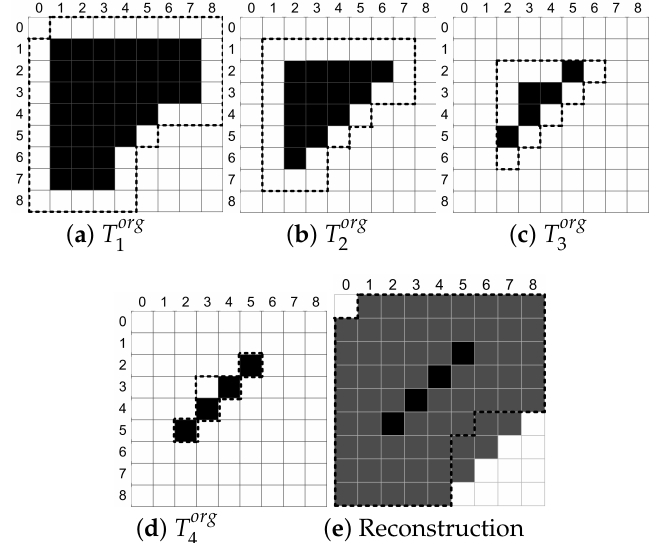
Figure 10. ( a – d ) The original thinning results at the 1st, 2nd, 3rd and 4th iteration by means of the fully-parallel thinning without the assistance of RHDP process. ( e ) Gray squares show the reconstructed pattern with our approach. It is obviously over-reconstructed due to the HDP